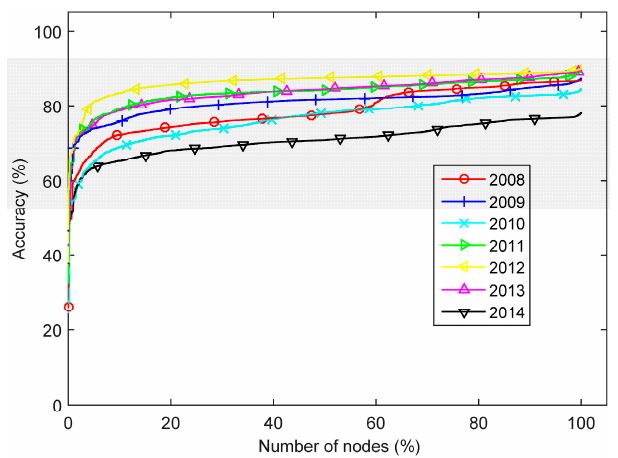
Figure 21. Potential revenue of a 10 MWh ESS dispatched in the RTM using DAM settlement prices as forecast. The results are presented as a percentage of the revenue captured by the same device in the RTM with perfect foresight.